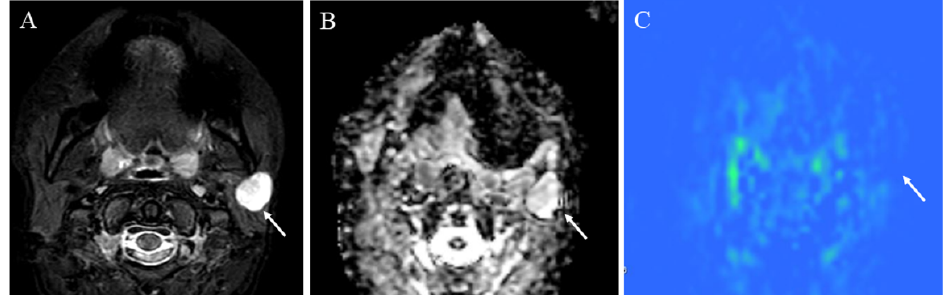
Figure 10. A 41-year-old female with pleomorphic adenoma of the left parotid gland: ( A ) STIR shows a mass with bright signal intensity (arrow); ( B ) ADC map shows increased diffusion (arrow) (ADC 10th percentile, 1.32 × 10 − 3 mm 2 /s and ADC mean of 1.48 × 10 − 3 mm 2 /s) ; ( C ) pCASL image shows low TBF (arrow) (TBF 50th percentile, 9.75 mL/100 g/min).